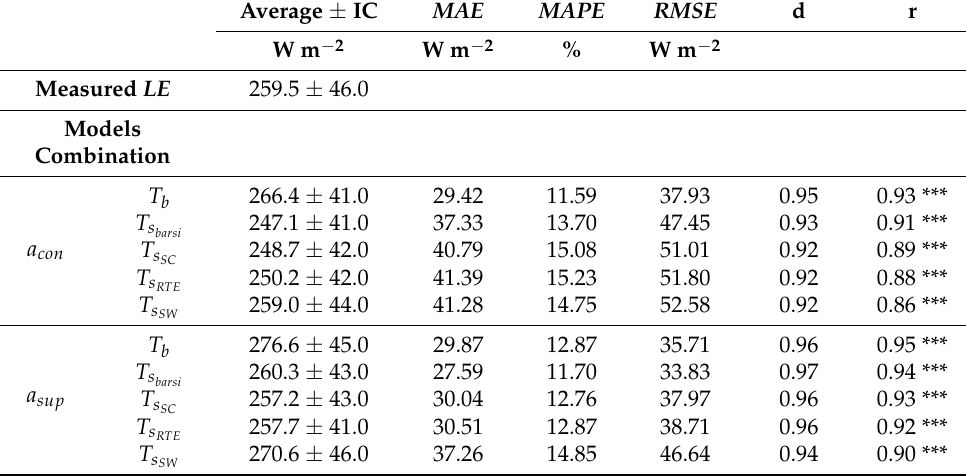
Table 9. Average ( ± 95% confidence interval) of the measured latent heat flux ( LE ; W m − 2 ) in the flux towers, and the average ( ± 95% confidence interval), mean absolute error ( MAE ), mean absolute percent error ( MAPE ), root mean square error ( RMSE ), Willmott coefficient (d), and Pearson correla- tion coefficient (r) of the estimated latent heat flux using the conventional ( a con ) and parameterized ( a sup ) surface albedo models combined with brightness temperature ( T b ) and surface temperature corrected by the Barsi model ( T s ), the single-channel model ( T s ), the radiative transfer equation SC barsi model ( T s ), and the split-window model ( T s ). Values with (***) indicate p -value < 0.001. RTE SW Average ± IC MAE MAPE RMSE